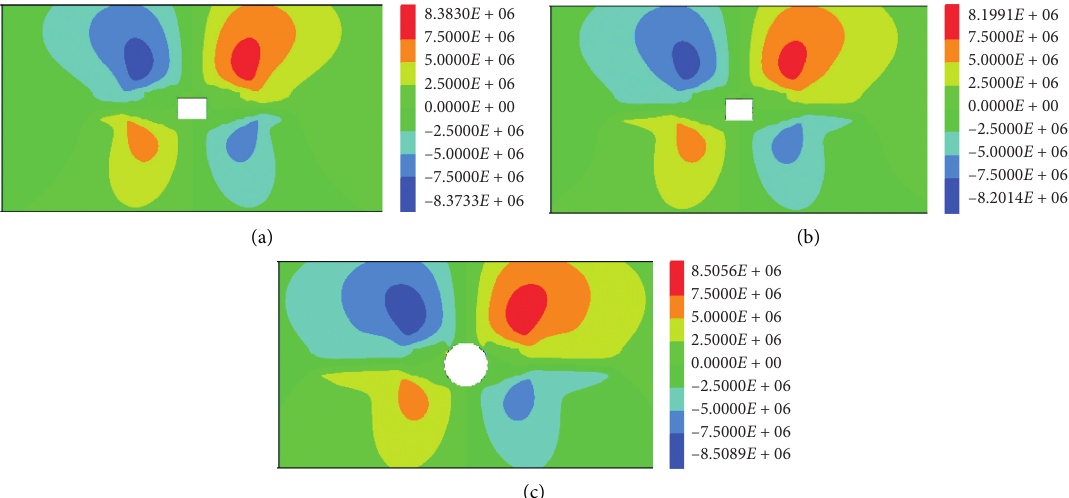
Figure 8: Shear stress of roof of different horizontal stresses: (a) 20MPa, (b) 30MPa, and (c) 40MPa.